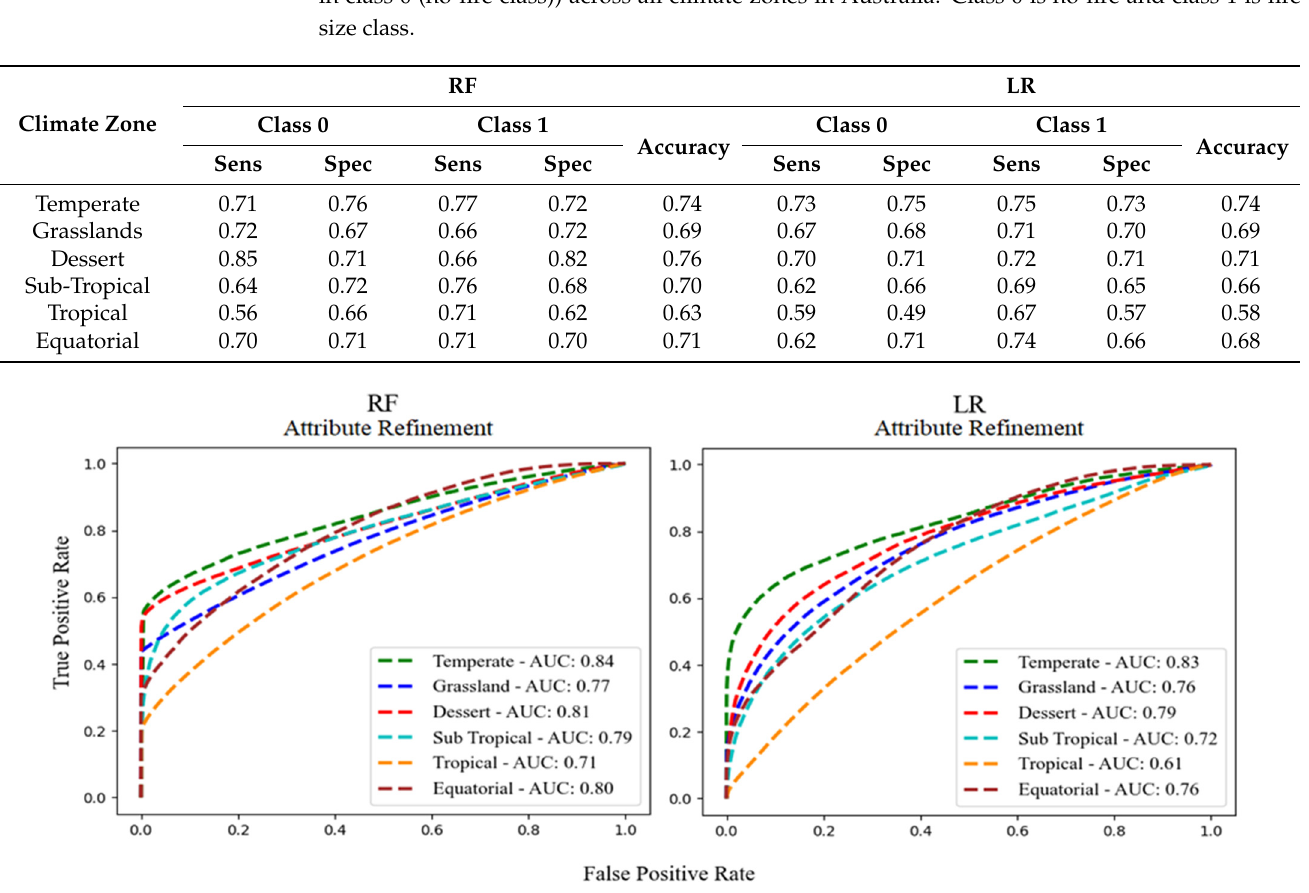
Figure 5. ROC and the respective AUC of class 1 (fire sizes) for RF and LR models trained with attribute refined data.